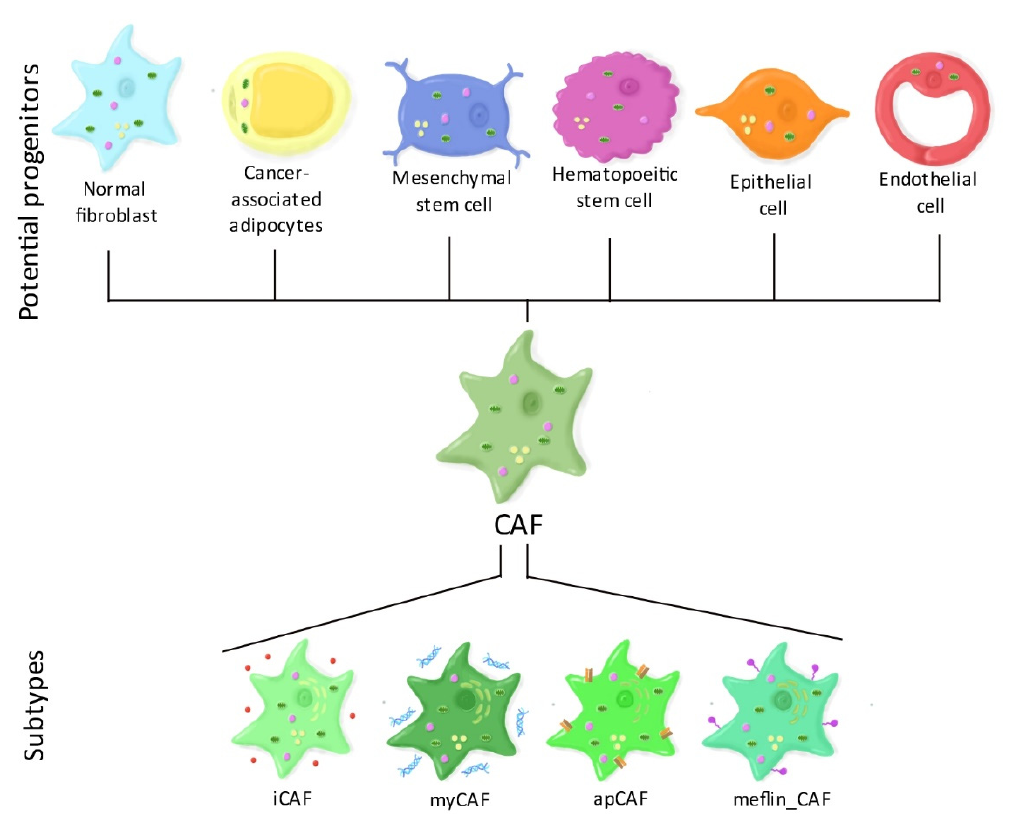
Figure 1. CAF heterogeneity. The origin of cancer-associated fibroblasts (CAFs) remains unclear. Several potential progenitors have been identified including normal fibroblasts, cancer-associated adipocytes, mesenchymal or hematopoietic stem cells, epithelial cells, and endothelial cells. Such heterogeneity in progenitors suggest that CAFs consist of several populations. Today, two principal CAF subtypes have been established: Inflammatory fibroblasts (iCAF) that secrete high levels of cytokines, and myofibroblasts (myCAF) that secrete extracellular matrix components. Additionally, new putative subtypes have been suggested such as antigen-presenting CAFs (apCAF) that express major histocompatibility complex (MHC) class II genes and could be responsible for CD4+ T-cells deactivation, and meflin-expressing CAFs (meflin-CAF), which were found to reduce tumor progression.